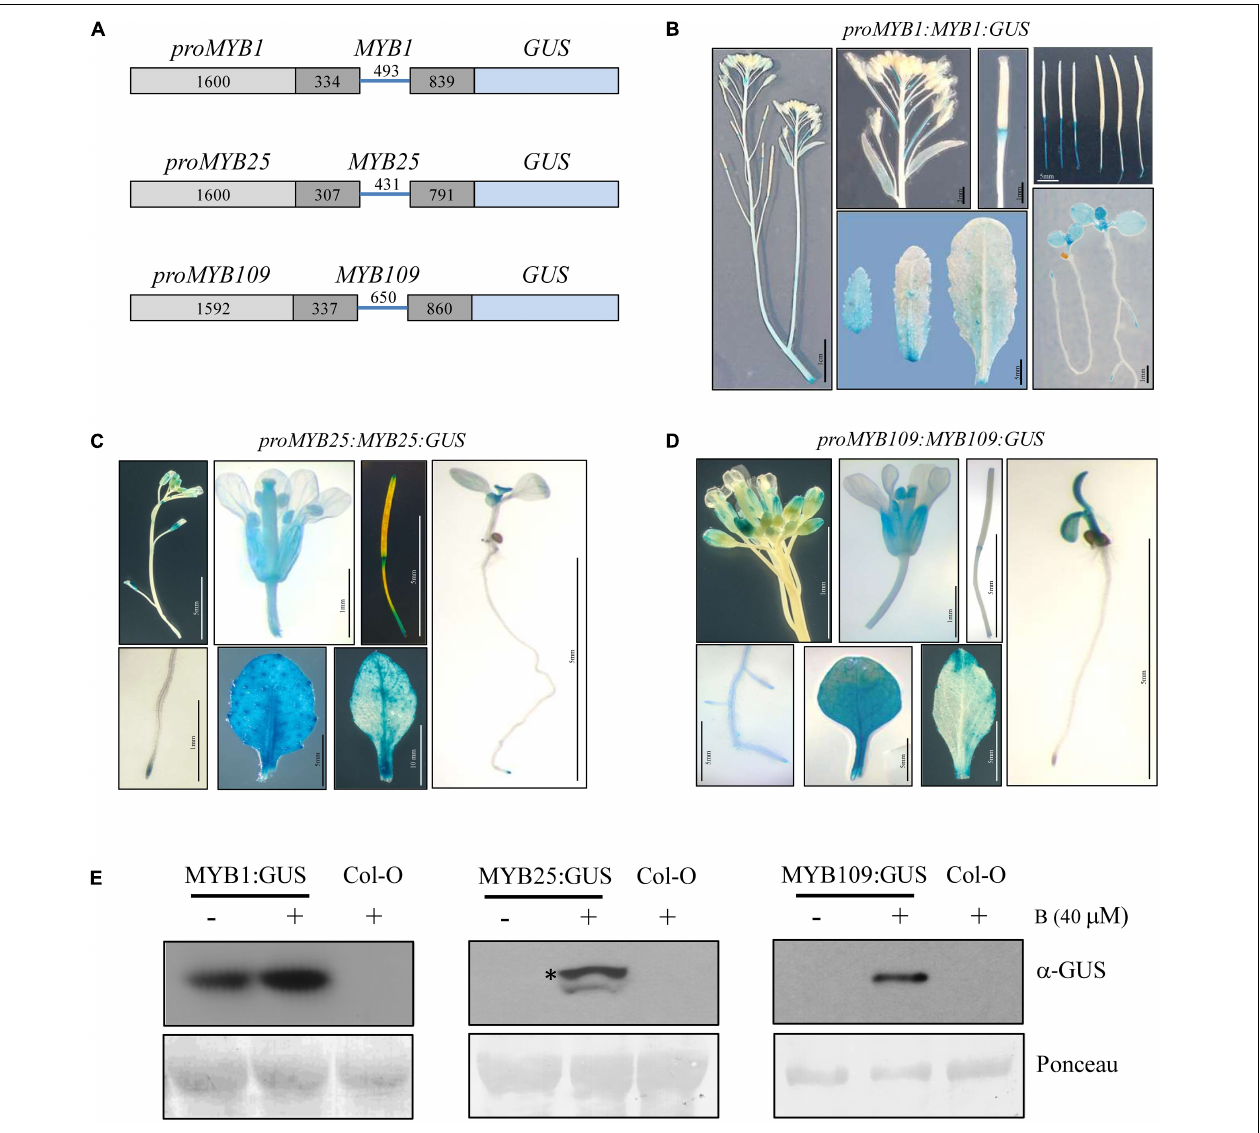
FIGURE 4 | Tissue specific expression pattern and stability of MYB1, MYB25, and MYB109. (A) Schematic drawings of MYB1, MYB25, and MYB109 genomic expression constructs. For all MYB constructs length of the cloned promoters and introns and exons are given in base pairs. Light gray bars represent promoter regions, dark gray bars represent exons, blue lines in between represent an intron. To accomplish translational fusions with GUS, the stop codons of MYB1 , MYB25 , and MYB109 coding regions were deleted. GUS expression patterns in plants carrying either proMYB1:MYB1:GUS (B) , proMYB25:MYB25:GUS (C) , or proMYB109:MYB109:GUS (D) expression constructs. (E) α -GUS Western blot analysis shows that overnight treatment with the proteasomal inhibitor bortezomib (B) leads to increased MYB1:GUS, MYB25:GUS, and MYB109:GUS proteins. Ponceau staining was used as loading control. The visible bands shown correlate in size with the large subunit of Rubisco ( ∼ 55 kDa). * indicates full-length MYB25:GUS protein.